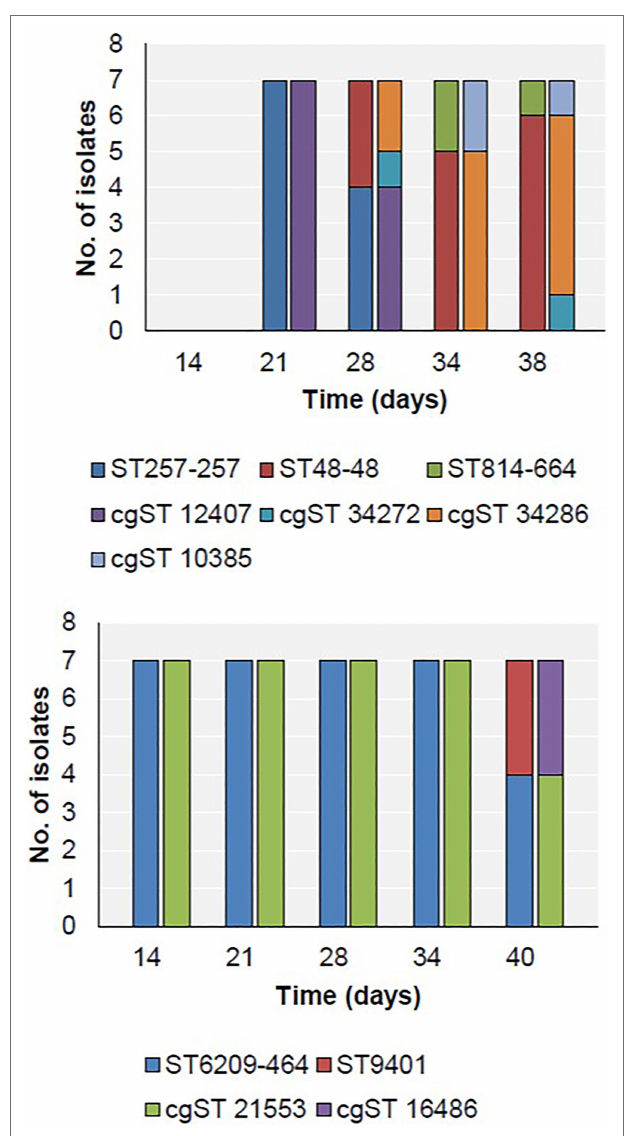
FIGURE 3 | Distribution of MLST (first bar at each time point) and cgST types (second bar at each time point) in Farm 1 (top) and Farm 2